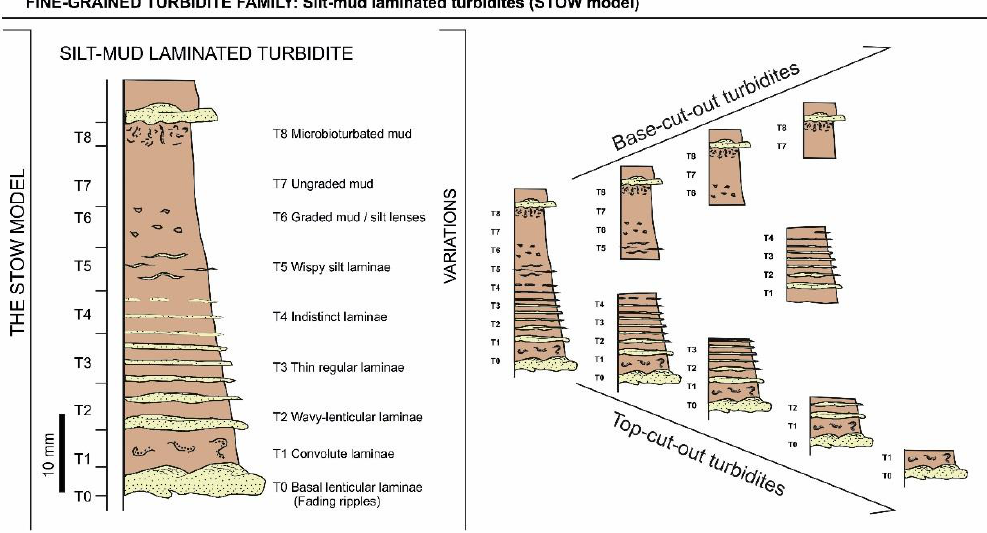
Figure 10. The fine-grained turbidite family for silt and mud turbidites. The ideal Stow facies model showing the complete sequence of divisions T0–T8 [21,89], and typical partial sequences found commonly in nature, is given.